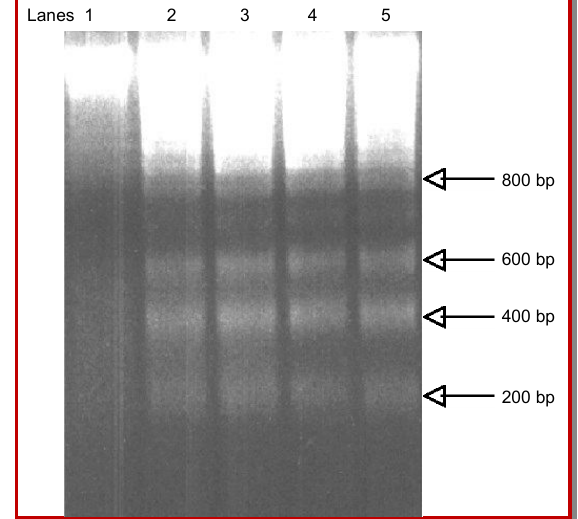
Figure 4: Genomic DNA fragmentation in CHO cells treated with T. violacea aqueous crude extract. Lanes 1 represents un- treated control; Lane 2 represents 1 µM staurosporine treated cells as positive control of apoptosis; Lanes 3, 4 and 5 represent 0.5, 1 and 2 mg/mL of the T. violacea crude aqueous extract. The ladder like pattern of bands indicated the genomic DNA